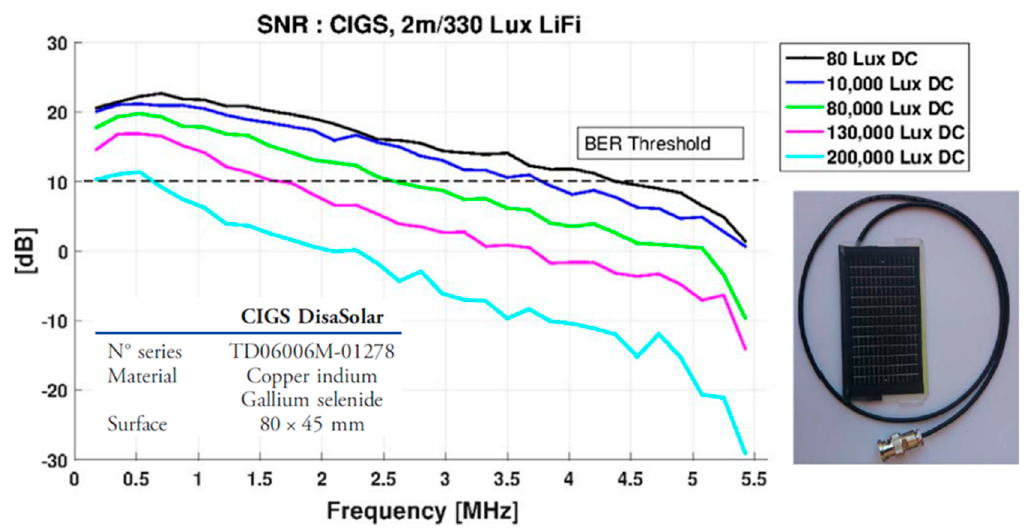
Figure 4. SNR of a DisasSolar CIGS module (illustrated in the picture on the right) as a function of ambient light level (DCO-OFDM). The BER threshold is indicated. Adapted with permission from [72] © The Optical Society.